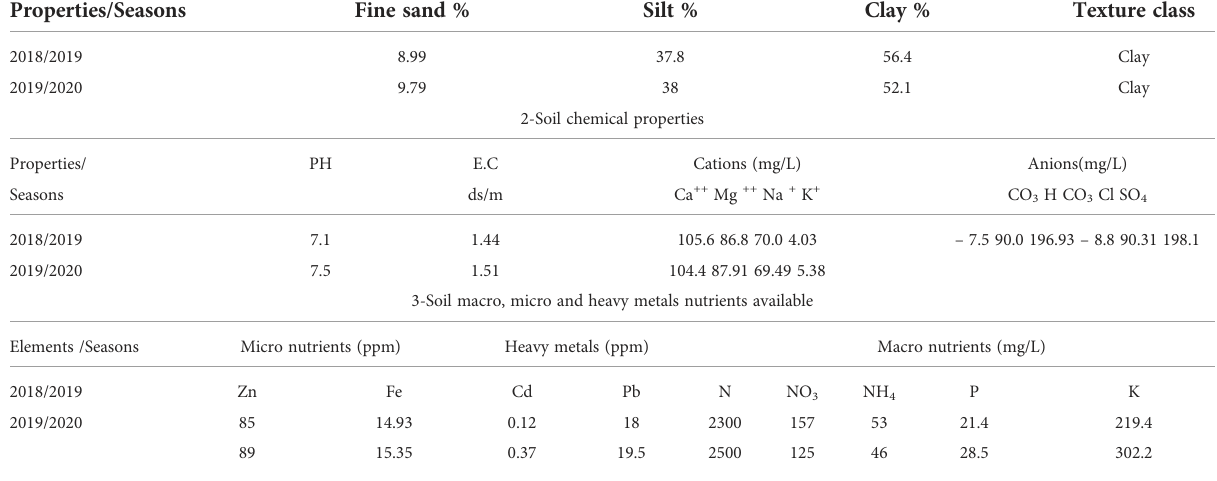
TABLE 1 Soil physical